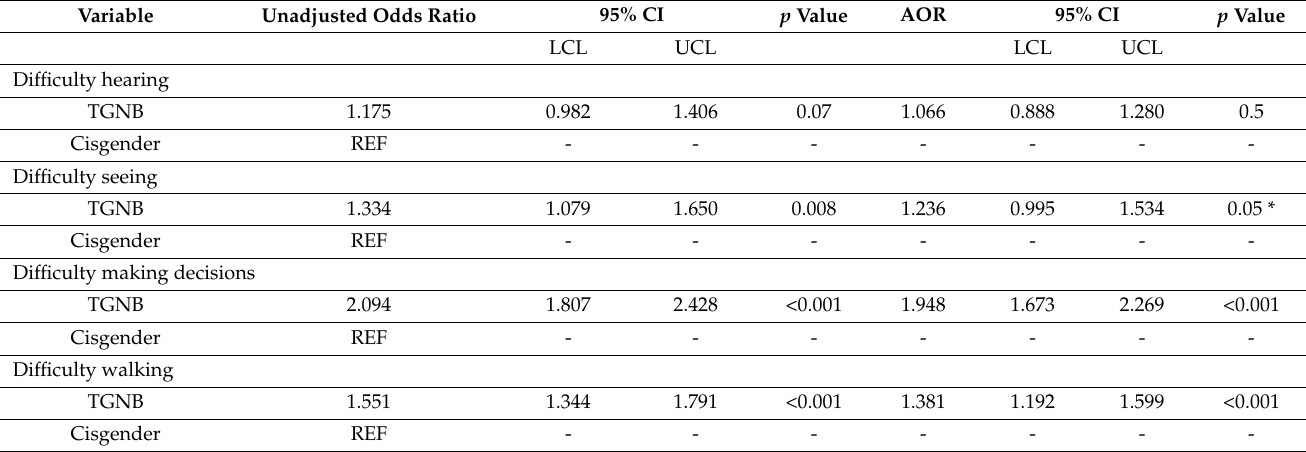
Table 5. Adjusted and unadjusted odds ratio for disabilities among matched